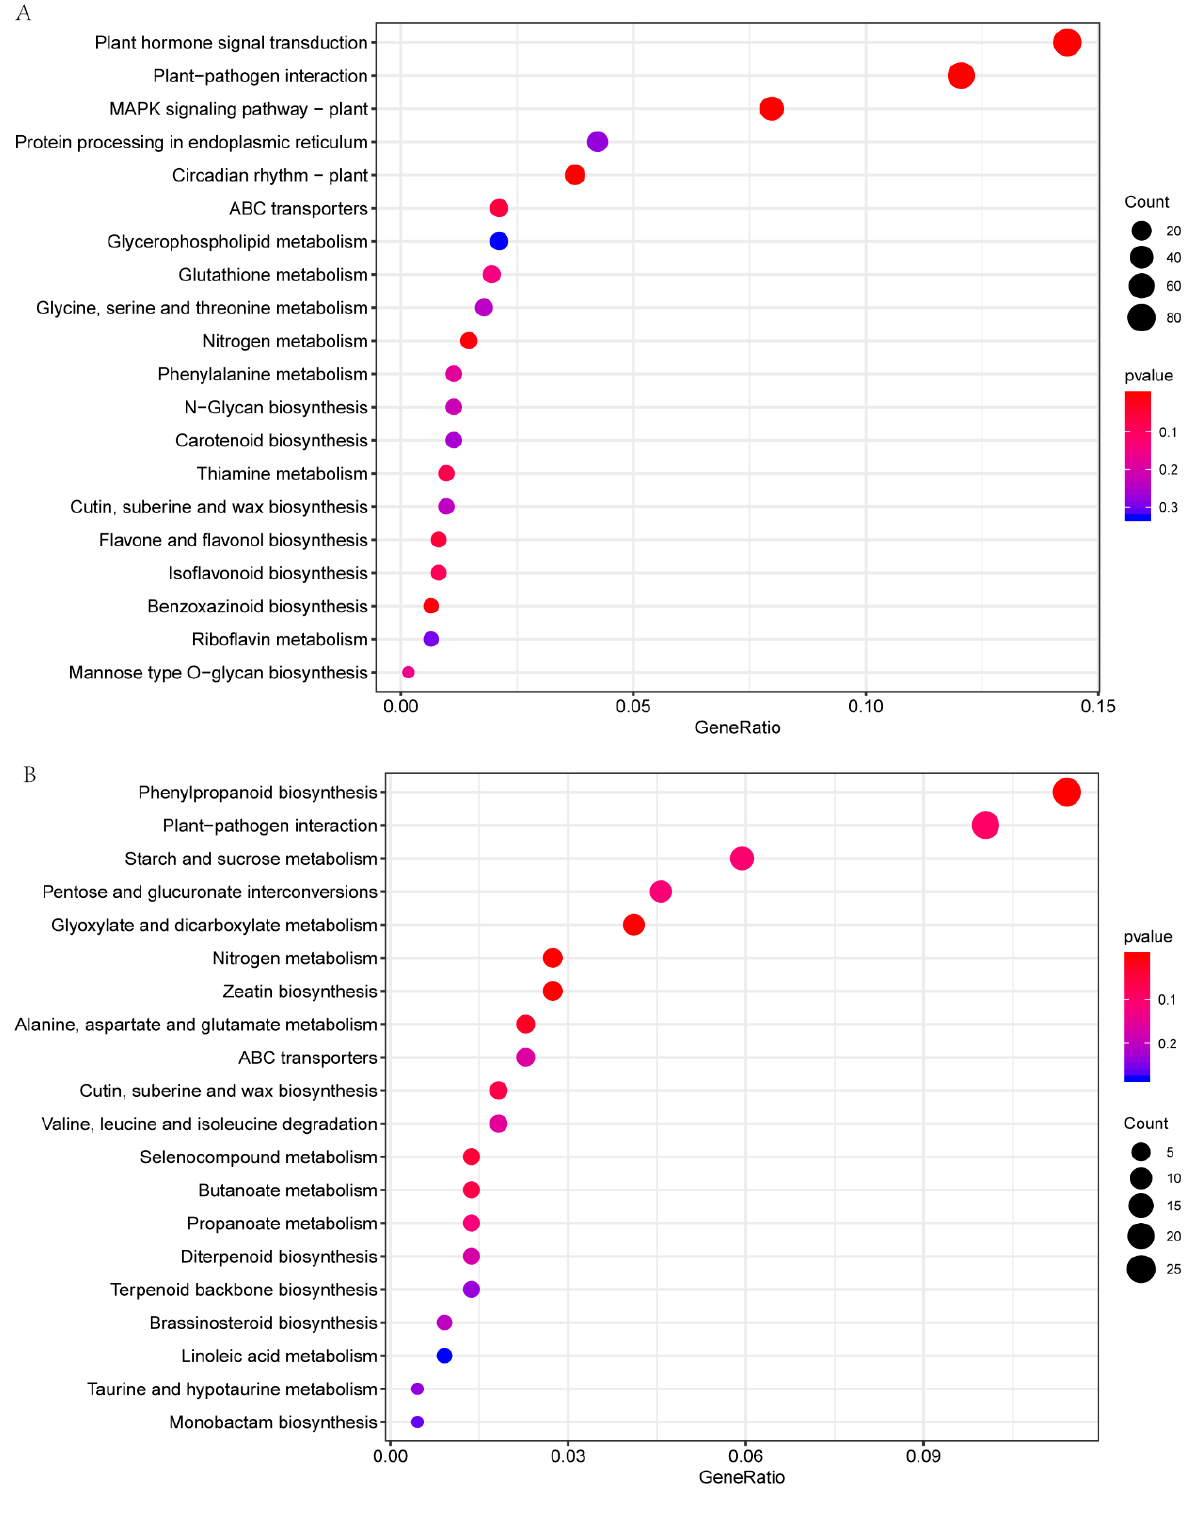
Figure 7. Dot plot diagram showing the most significantly enriched 20 items in KEGG analysis. ( A ) Comparing a pair of CT57S vs. CT90R in leaves. ( B ) Comparing a pair of CT57S vs. CT90R in roots.